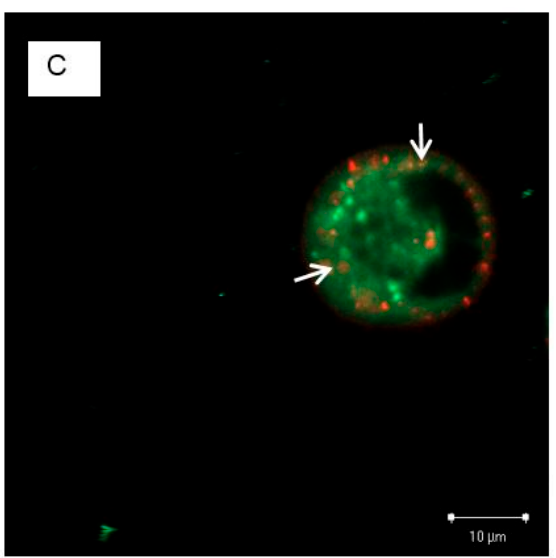
Figure 4. Localization of EGFR and PS NPs in A431 cells. Typical three-color merged confocal fluorescence microscopy images of A431 cells stained with: ( A ) anti-EGFR antibody; or exposed to: ( B ) 100 ng/mL EGF; or ( C ) 100 ng/mL EGF + 10 µg/mL NPs. Without EGF, EGFR distributed homogeneously on the cell membrane. In the presence of EGF, EGF induced slight aggregation of EGFRs. The presence of EGF and PS NPs resulted in co-localization of EGFRs and NPs in the cytoplasm. EGFRs are shown in red, NPs in green, and the cell nucleus (stained with DAPI) in blue.